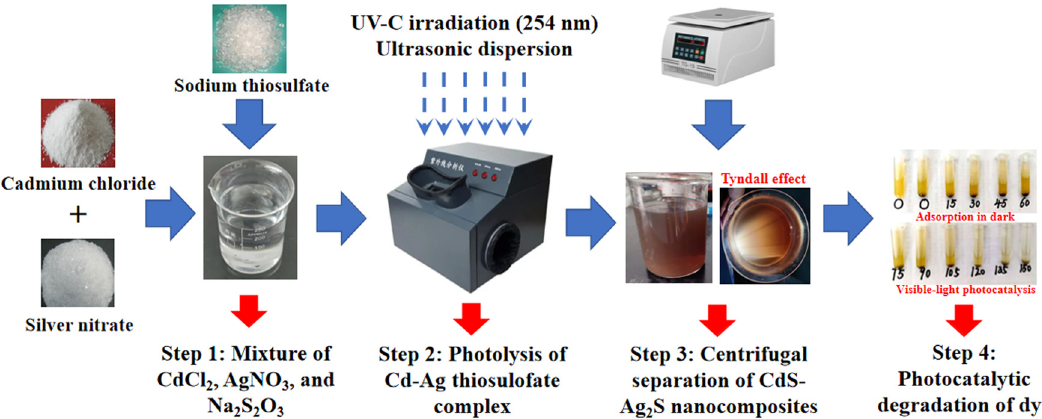
Figure 1: Schematic diagram of the CdS – Ag 2 S